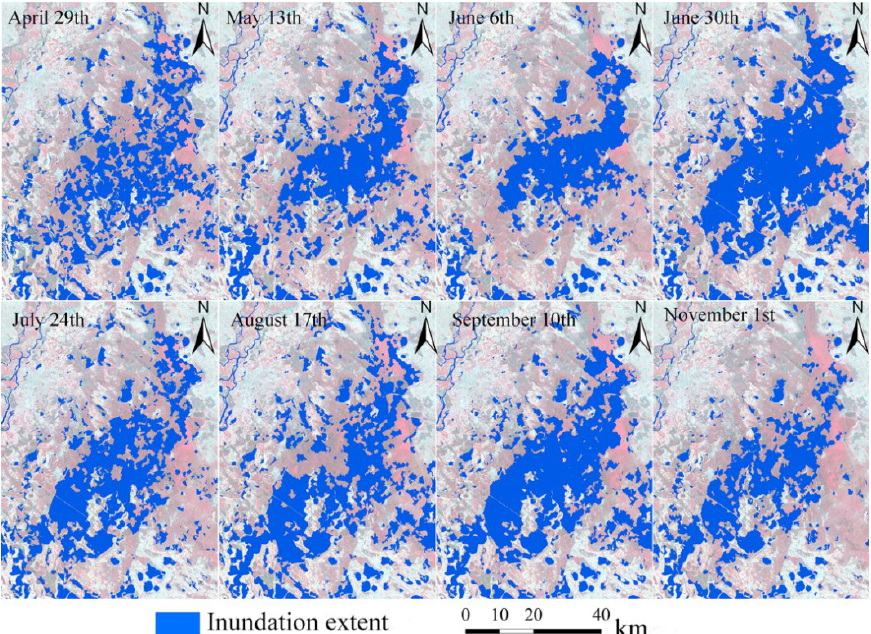
Figure 3. Dynamics of the flood inundation extent in Zhalong wetlands over the 2015 hydrological year, blue color represents the inundation extent. Table 1. Accuracies of the single-temporal flood situation classification results (OW = open water, SAV = submerged aquatic vegetation, EAV = emerged aquatic vegetation, BS = bare soil).